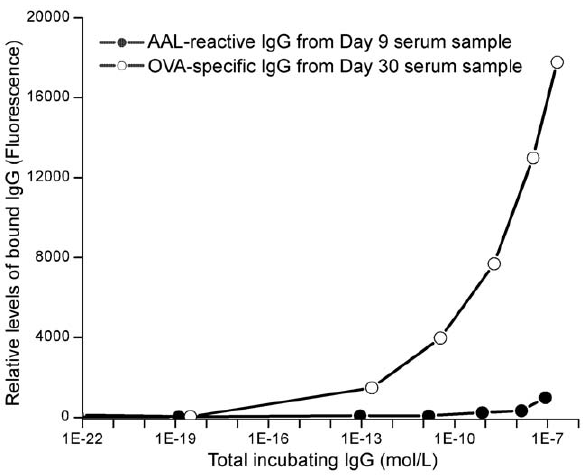
Figure 4. Comparison of OVA-binding affinities of AAL-reactive IgG and OVA-specific IgG at peak levels. AAL-reactive IgG and OVA specific IgG were purified from OVA/CAF inoculated rabbit by using OVA Agarose and AAL Agarose beads immunoprecipitation as described in Methods and Materials. The AAL-reactive IgG was purified from Day 9 serum sample, and the OVA-specific IgG was purred from Day 30 serum sample of rabbit 2 (as shown in Table 1), respectively. The purified serum samples were serially diluted and applied onto a protein/antibody microarray that immobilized OVA protein and donkey F(ab 9 ) 2 anti-rabbit IgG spots. The bound IgG levels on OVA protein, and the concentration of IgG were measured simultaneously. The OVA- bound AAL-reactive IgG and OVA-specific IgG were plotted as a function of their concentration measured by the immobilized donkey F(ab 9 ) 2 anti-rabbit IgG. ing GlcNAc (G1BF), or fucosylated mono-galactosylated lacking one GlcNAc (G1F-GlcNAc), and 39.4% are fucosylated agalacto- syed (G0F), fucosylated agalactosylated lacking one GlcNAc (G0F- GlcNAc), and fucosylated agalactosylated with bisecting GlcNAc (G0BF). G2 species, such as fucosylated di-galalctosylated (G2F) or fucosylated di-galactosylated with bisecting GlcNAc (G2BF) were not found in purified AAL-reactive IgG. Fucosylated glycoforms in AAL-reactive IgG were 3.5 times more abundant than those in normal rabbit IgG.